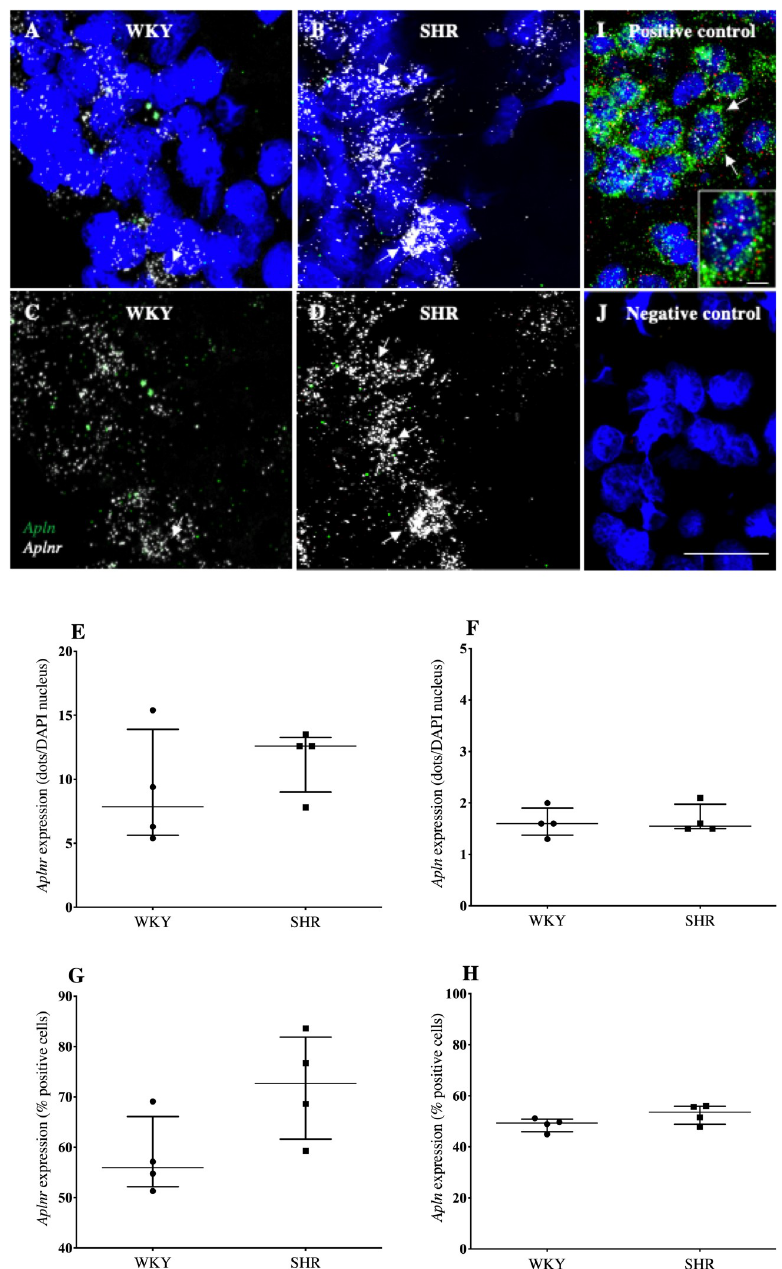
Fig 1. Aplnr and apln expression in the OVLT of WKY rats and SHRs. (A-D) Representative fluorescent images showing expression of aplnr and apln in the OVLT of WKY rats (A and C) and SHRs (B and D). DAPI: blue, aplnr : white, apln : green. DAPI removed from C and D to highlight distribution of mRNA. Arrows point to representative cells with relatively high levels of aplnr expression. (E-H) Graphs showing gene expression as a function of dots/DAPI nuclei or percentage positive cells for aplnr (E and F) and apln (G and H) expression. n = 4/group. Data is median [IQR]. Sections were also analysed with positive (rat polymerase (RNA) II (DNA directed) polypeptide A, transcript variant 1 ( POLR2A; white dots), peptidylprolyl isomerase ( PPIB; red dots) and ubiquitin C ( UBC ; green dots)) (I) and negative ( DapB (of Bacillus subtilis strain)) (J) with nuclei counterstained with DAPI (blue). The inset shows a high magnification image of the cell depicted by white arrows. Scale bar = 50 μ m and 10 μ m for the inset image.